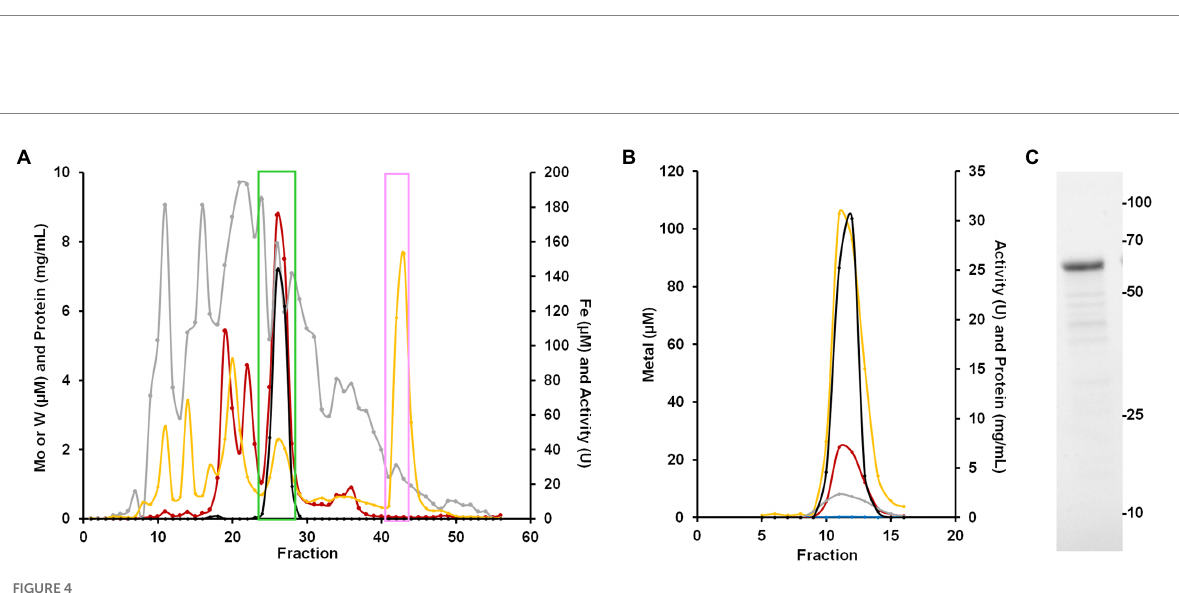
FIGURE 4 Purification of BmWOR and BmFd. (A) Elution profile from the first QHP column showing benzaldehyde oxidation activity (black), protein (gray), Fe (yellow) and W (red). The green box indicates fractions that were pooled for the BmWOR purification and the pink box indicates the fractions that were pooled for the BmFd purification. (B) BmWOR elution profile from the final MonoQ column showing benzaldehyde oxidation activity (black), protein (gray), Fe (yellow), W (red) and Mo (blue). (C) SDS-PAGE gel of purified BmWOR from the peak MonoQ fraction showing a major band at 65